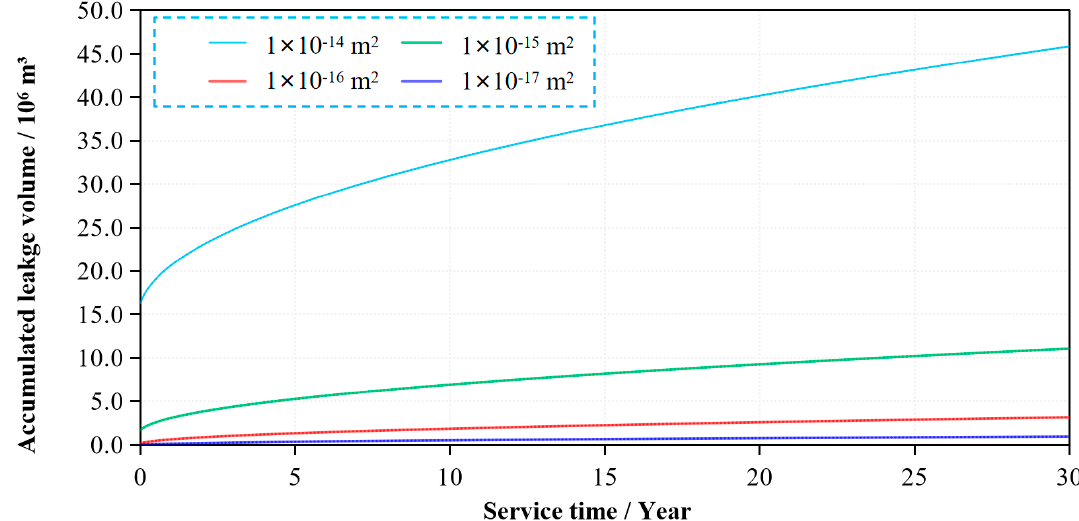
Figure 12. Cumulative water leakage amount of the coal pillar dam with different permeability.